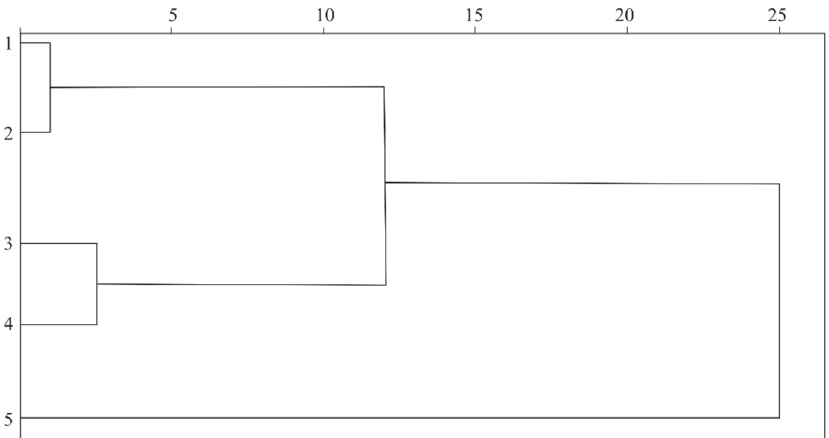
Figure 15. The results of hierarchical cluster analysis based on the occurrence of numerals in texts by Ilf and Petrov (Nos. 1, 2), Kataev (Nos. 3, 4), and Bulgakov (No. 5). The horizontal scale indicates the “distance” between clusters in conventional units. Texts Nos. 1-5, combined into clusters, are indicated in the article.